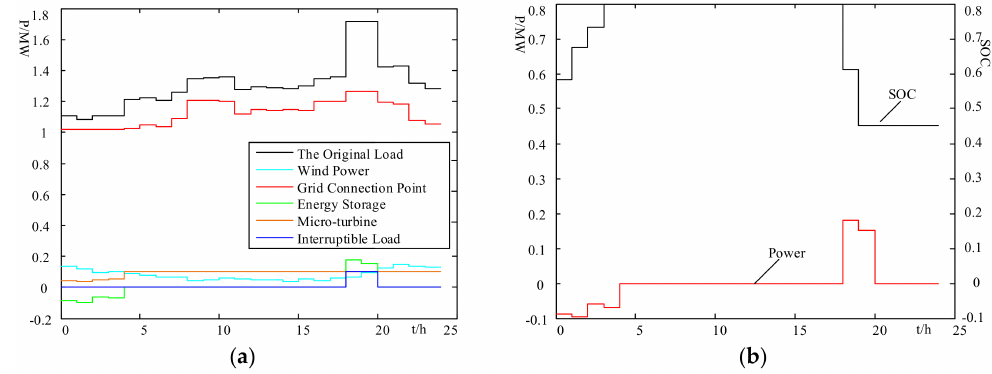
Figure 6. Results of day-ahead optimal dispatch: ( a ) Power curves of each device; ( b ) state of the